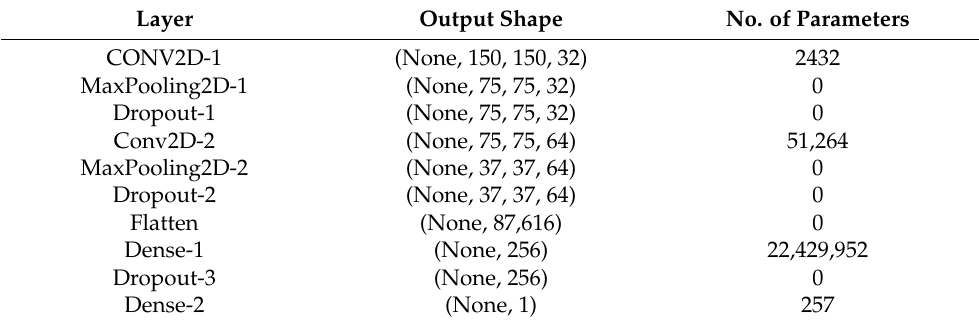
Table 1. Summary of the CNN models used in this